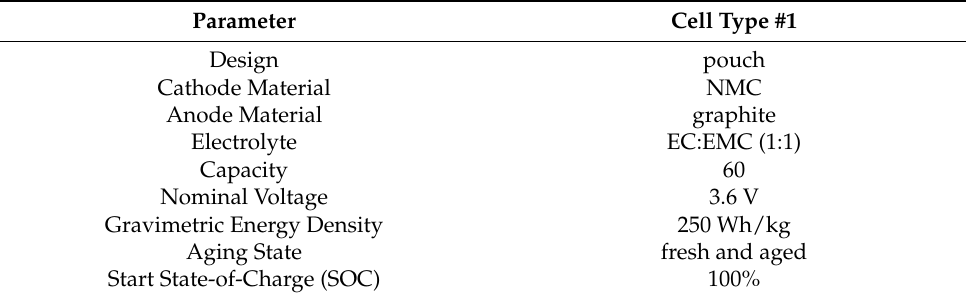
Table 1. Specification of the investigated automotive Li-ion cells.